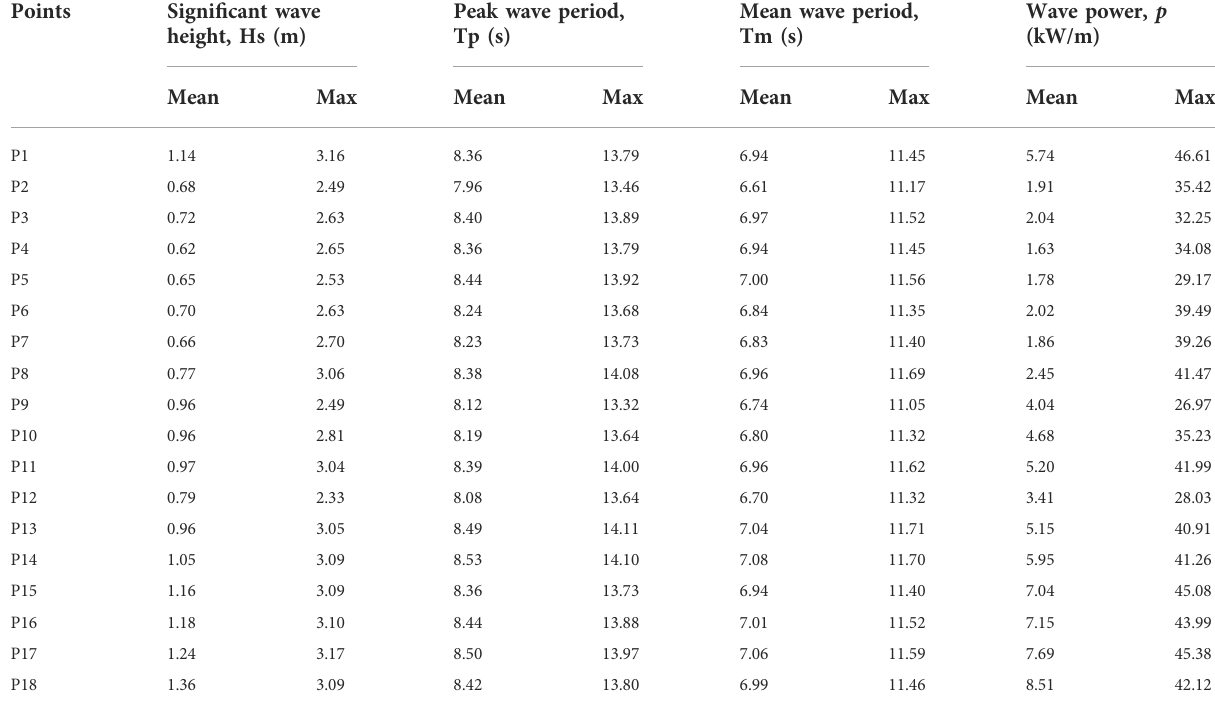
TABLE 2 Annual averaged and maximum values of wave height, wave period and wave power at selected locations around the Agatti island. Points